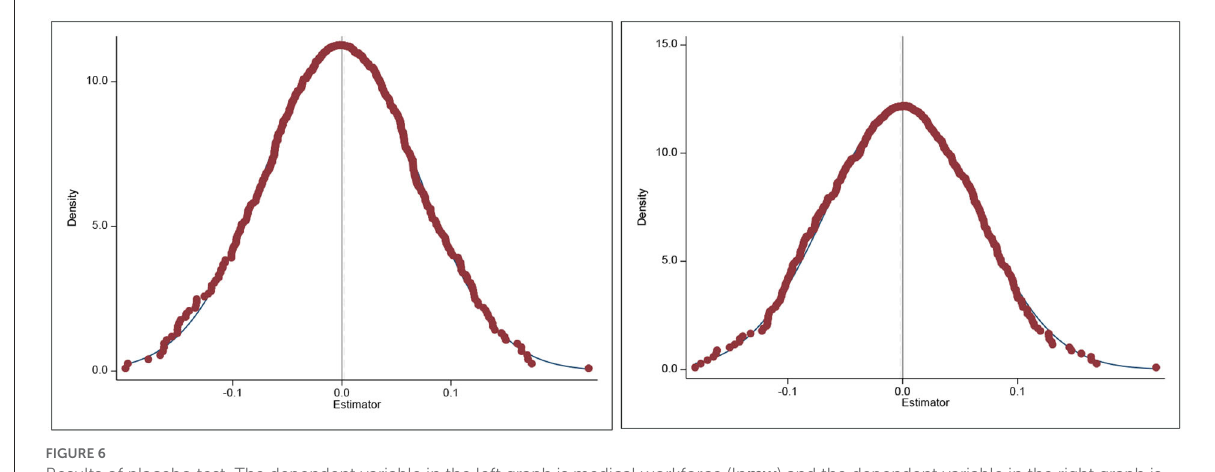
FIGURE6 Results of placebo test. The dependent variable in the left graph is medical workforce (ln mw ) and the dependent variable in the right graph is medical infrastructure (ln mi ). Treatment groups were randomly drawn 500 times in the control group by Monte Carlo simulation and DID regression was performed. Plot the obtained regression coefficients as a distribution graph. This figure reports the results of health care environment of non-pilot cities as a dependent variable, presenting a normal distribution with an average value of 0.